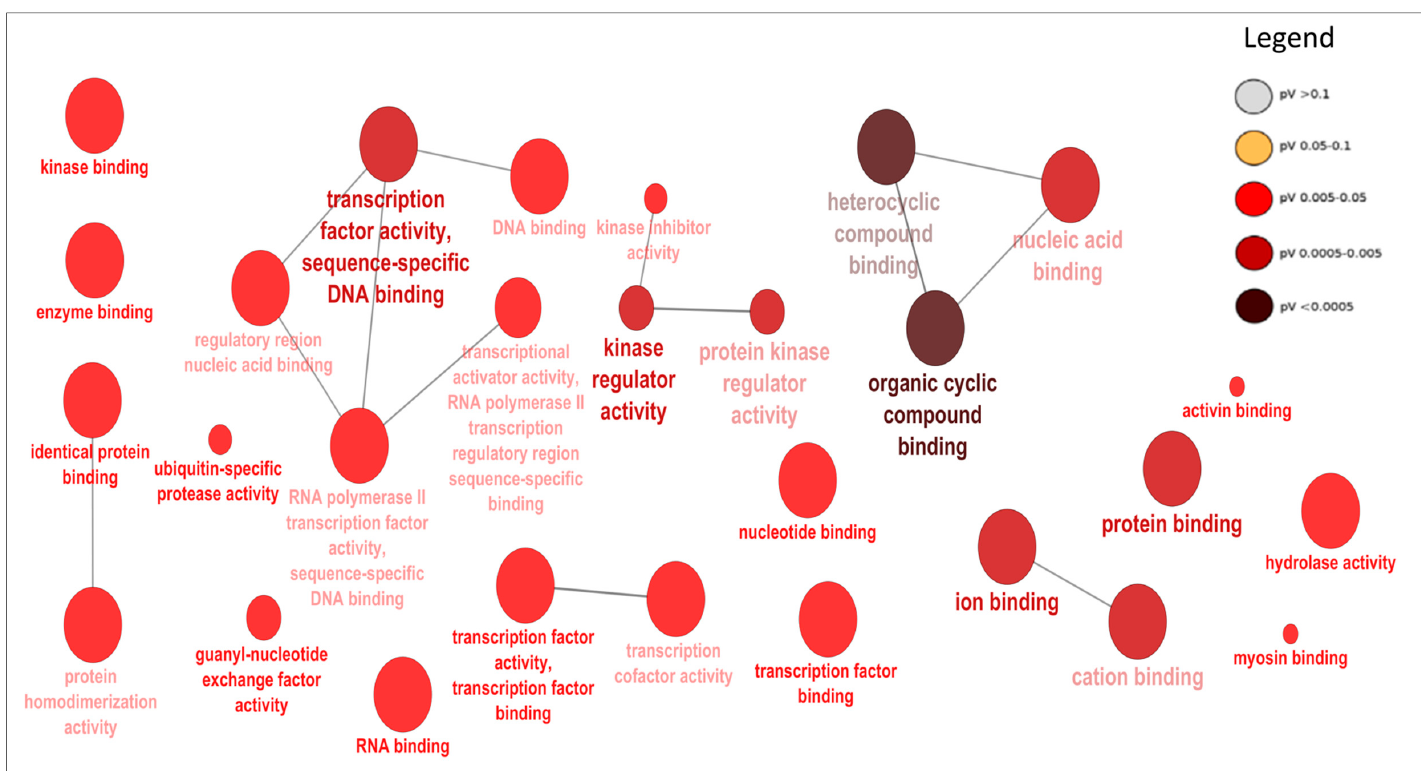
Figure 4. The ClueGO results for molecular functions gene ontology terms enrichment for target genes of differentially expressed miRNAs and relationships between them. The nodes (round shape) represent gene ontology terms, node color represents the level of significance as indicated in the legend, while node size reflects the number of genes enriched in each gene ontology term.